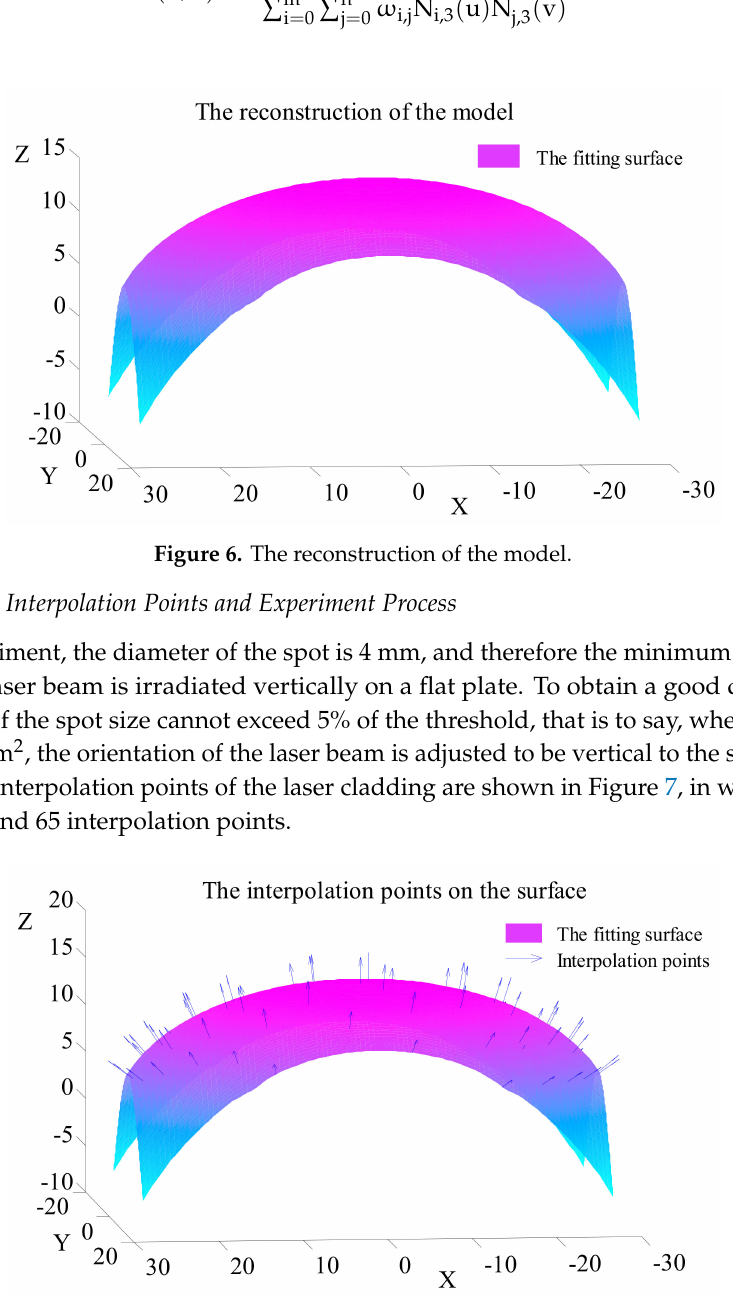
Figure 7. The interpolation points on the